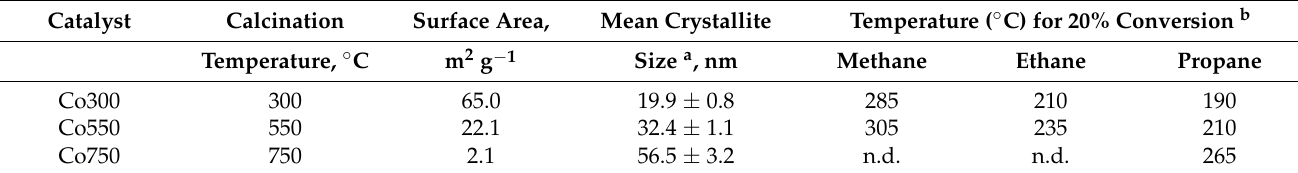
Table 1. Main characteristics of the catalysts based on cobalt mixed